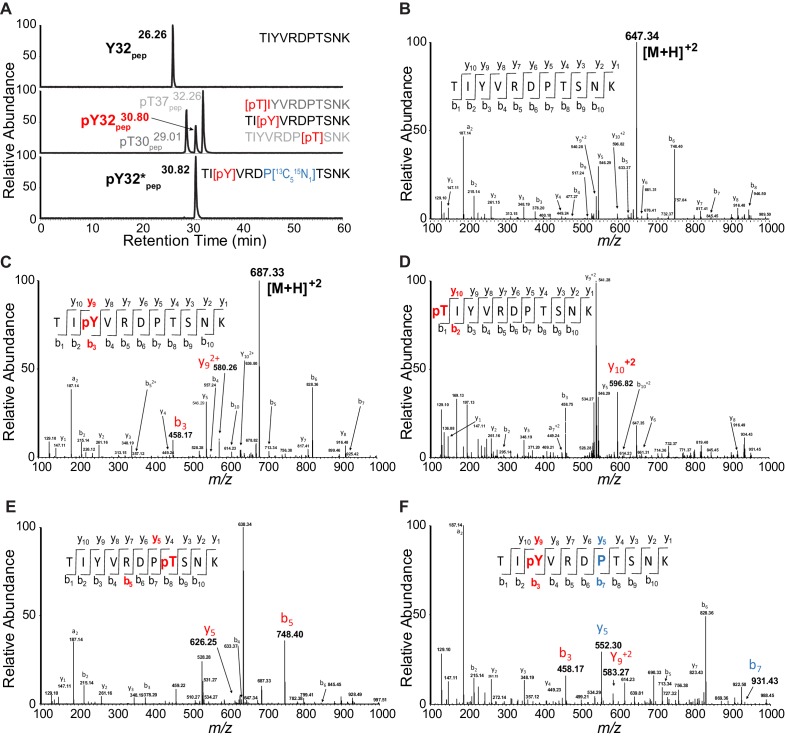
PRM chromatograms and spectra for unphosphorylated and phosphorylated LynA Y32 tryptic peptides.(A) PRM chromatograms illustrating resolution of synthetic phosphorylated and unphosphorylated peptides (top and middle panels), resolution of pY32 and synthetic threonine-phosphorylated (pT) species (middle panel), and coelution of unlabeled pY32pep with isotope-labeled pY32*pep (middle and bottom panels). Species detected in LynA IPs (Y32 pep, pY32 pep, and pY32*pep) are indicated in bold type, phosphorylation sites are shown in red, and the isotope-labeled proline residue is shown in blue. (B–F) MS/MS spectra for synthetic peptides corresponding to tryptic peptides containing LynA Y32. The expected fragmentation pattern for each is indicated with phosphoions labeled in red/bold and isotope-labeled ions labeled in blue/bold. (B) MS/MS for Y32pep run at 647.3435 m/z. (C) MS/MS for pY32pep run at 687.3267 m/z, with highlighted fragment ions from phosphoY32. (D) MS/MS for pT30pep run at 687.3267 m/z, with highlighted fragment ions from phosphoT30. (E) MS/MS for pT37pep run at 687.3267 m/z, with highlighted fragment ions from phosphoT37. (F) MS/MS for pY32*pep run at 687.3267 m/z, with highlighted fragment ions from phosphoY32 and the isotope-labeled proline residue.